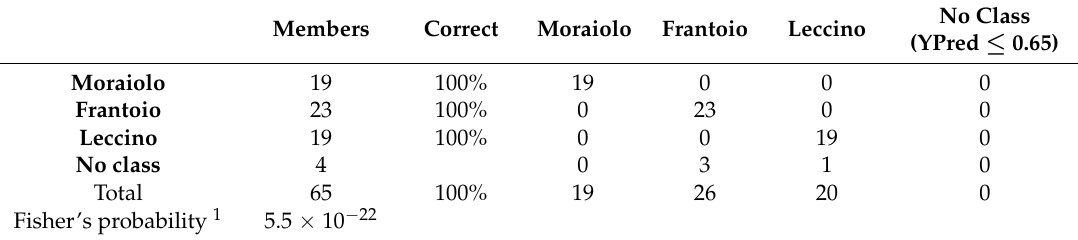
Table 1. Misclassification table for the model. Y predicted value estimates class affiliation and the limit of 0.65 was chosen for the assignment of observations to a specific class. The observations with no Y predicted below 0.65 were not assigned (no class column). Each observation was assigned to the nearest class.